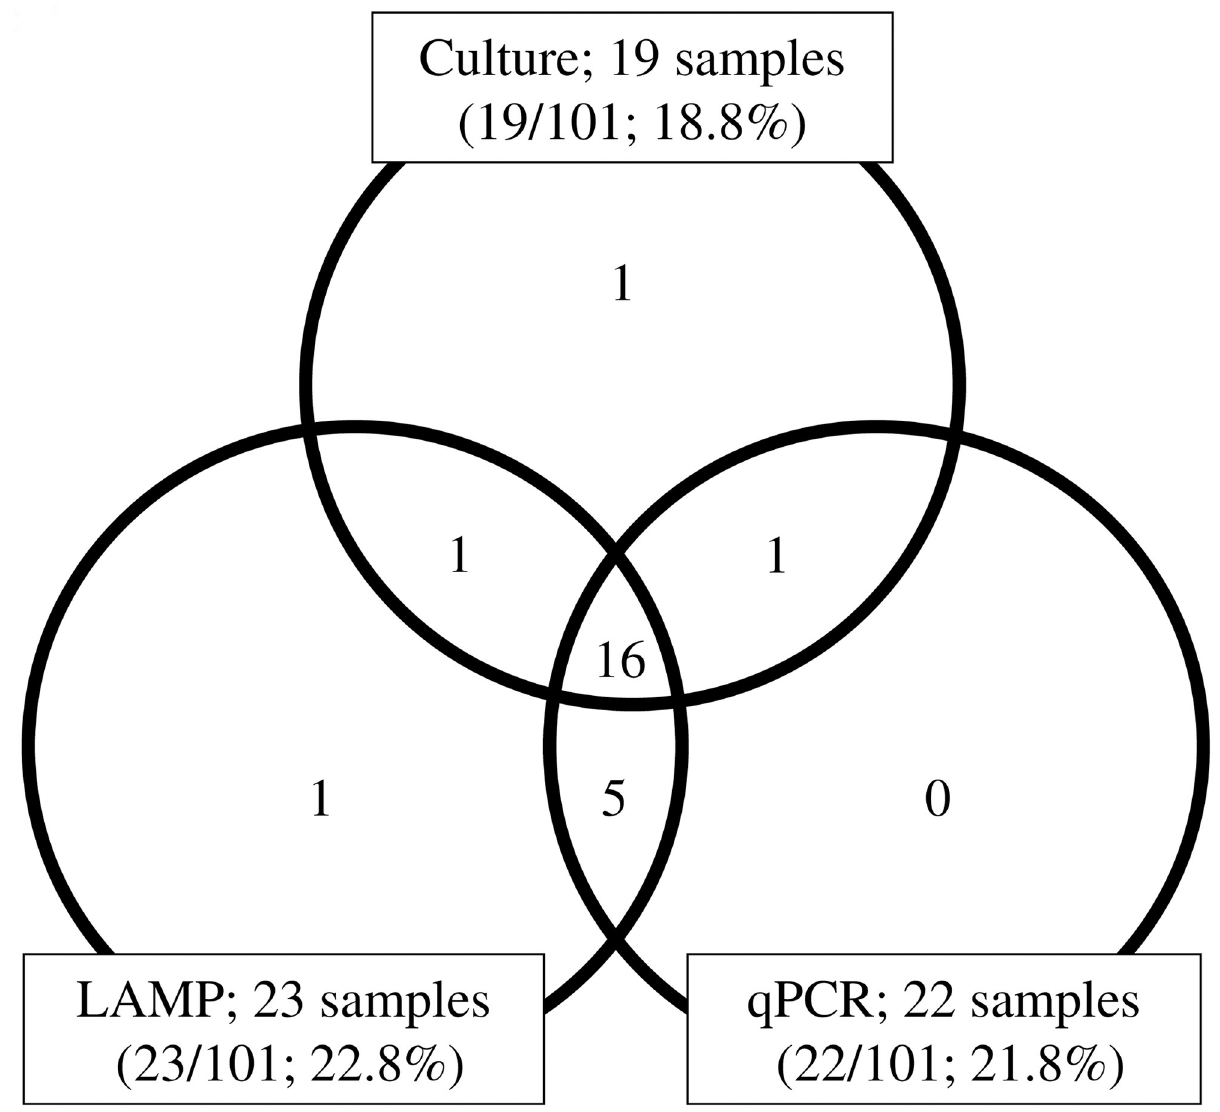
Fig 2. Detection of Ureaplasma species in tracheal aspirates analyzed by culture, LAMP, and qPCR. In each field of the venn diagram, the number of samples positive for Ureaplasma species is given. LAMP; Loop-mediated isothermal amplification. qPCR; Quantitative real-time PCR.